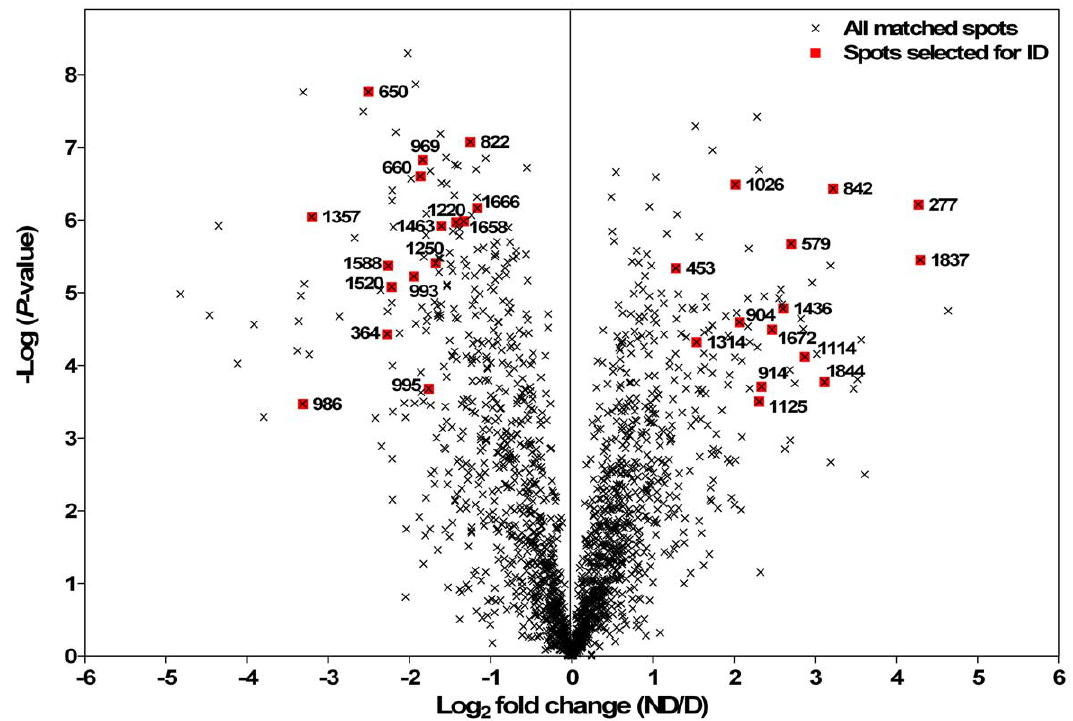
Figure 4. Graphical representation of quantitative proteomics data. Proteins are ranked in a volcano plot according to their statistical P - value (y-axis) and their relative abundance ratio (log 2 fold change) between nondiapausing (ND) and diapausing (D) phenotypes (x-axis). Off-centred spots are those that vary the most between both groups. All matched spots are represented (symbol 6 ) together with the 30 spots selected for identification (symbol & ) with mass spectrometry.